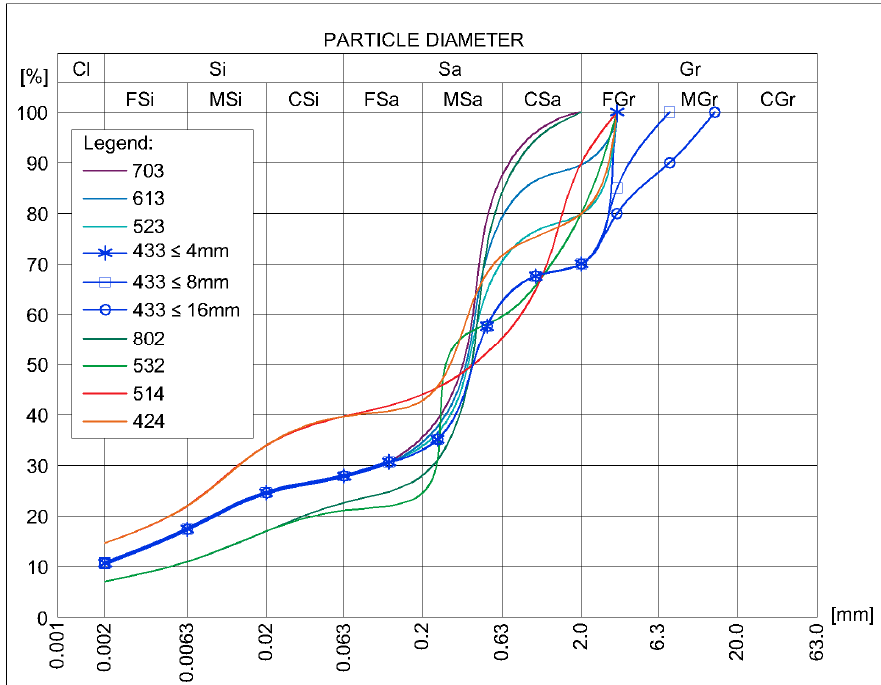
Figure 6. Particle size distribution of soils used for laboratory tests.